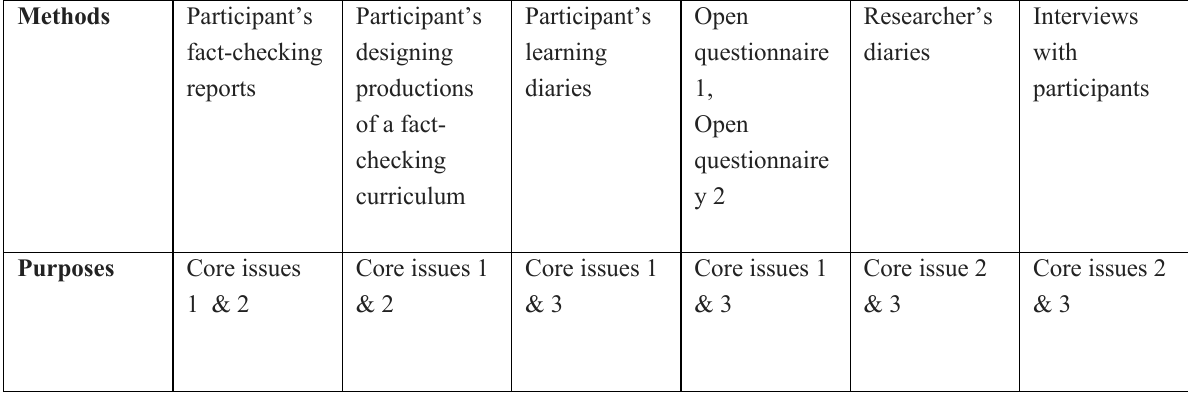
Data for Core Issues (Tekoniemi,